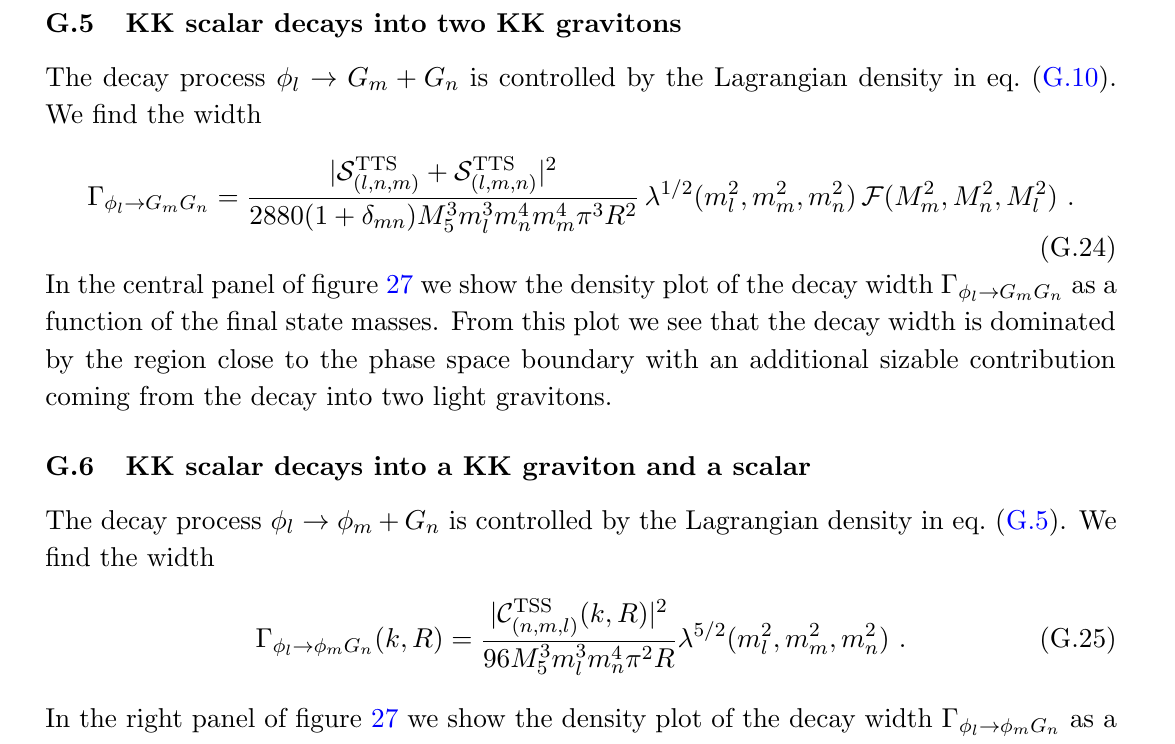
Figure 27 . Density plot of the decay widths (cid:0) (cid:30) (cid:0) (cid:30) (right panel) as a function of the (cid:12)nal state masses. The example shown is M 5 = 10 TeV, l ! (cid:30) m G n k = 10 GeV, for mode l = 1000. The corresponding mass of the decaying particle is m 1000 ’ 1